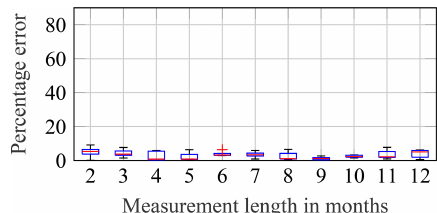
Figure 25. Convergence of the percentage error of predicted yearly damage values using the binning approach for increasing measure- ment lengths. Box plot shows data from five different measurement periods starting in the